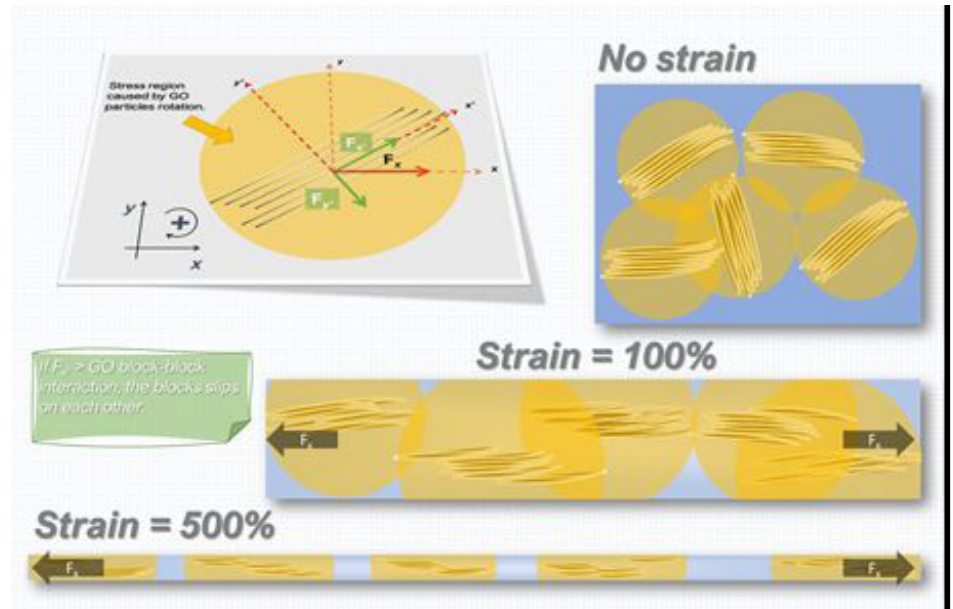
Figure 13. Proposed mechanism for GO microdomains movements role for PCU